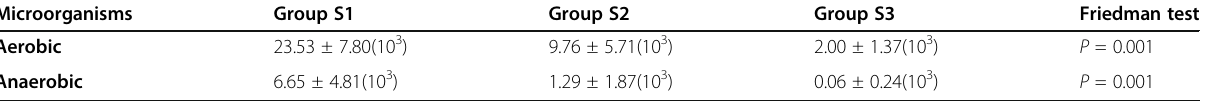
Table 4 Comparison of the mean colony forming units of aerobic and anaerobic microorganisms among the three groups Microorganisms